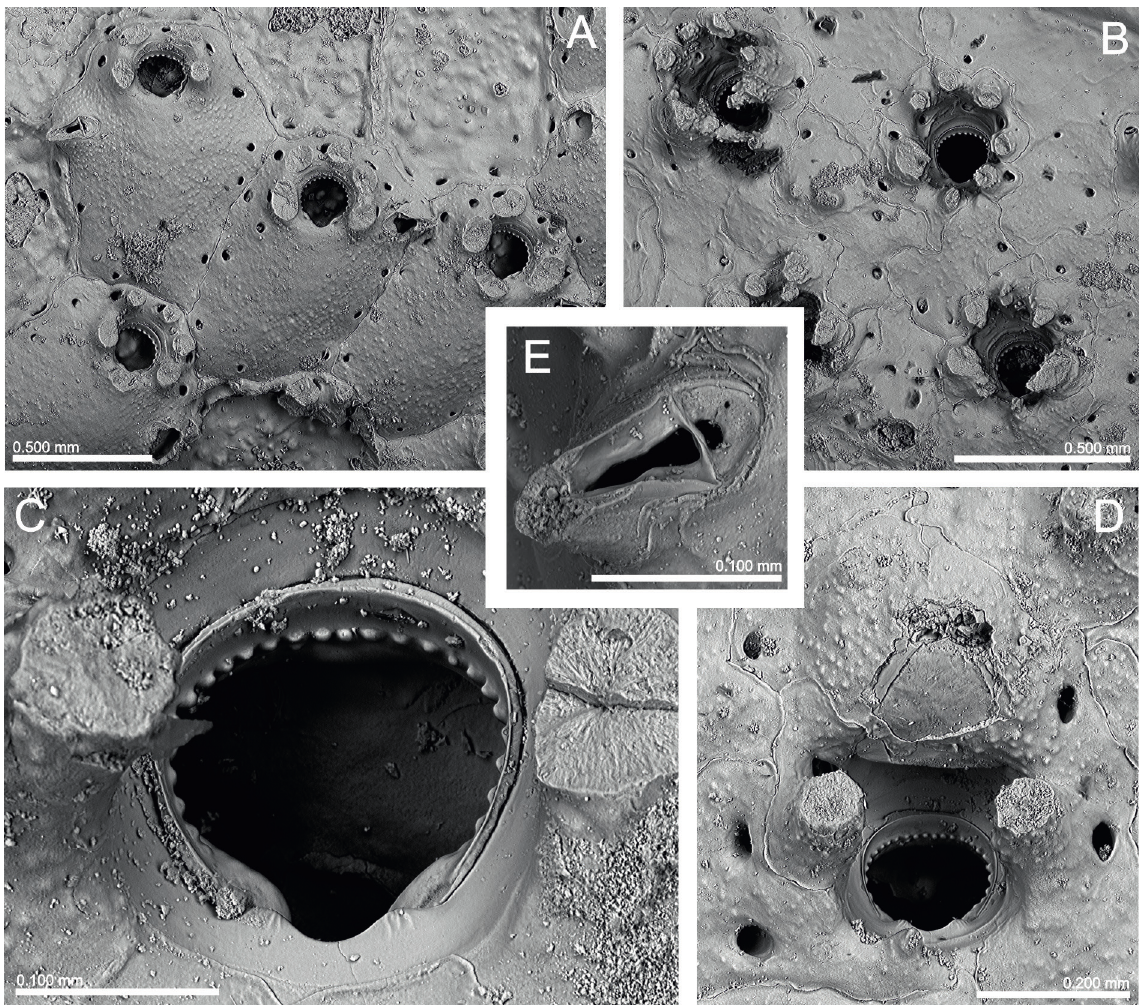
Fig. 7. Rhynchozoon confusum (Calvet, 1906) comb. nov. A . Young autozooids in the colony margin; note the presence of small adventitious avicularia (MNHN 2354, paralectotype). B . Older zooids with indistinct margins and well-developed oral knobs (MNHN 494, paralectotype). C . Primary orifice (MNHN 4007, lectotype). D . Same, ovicell. E . Detail of an adventitious avicularium (MNHN 494,